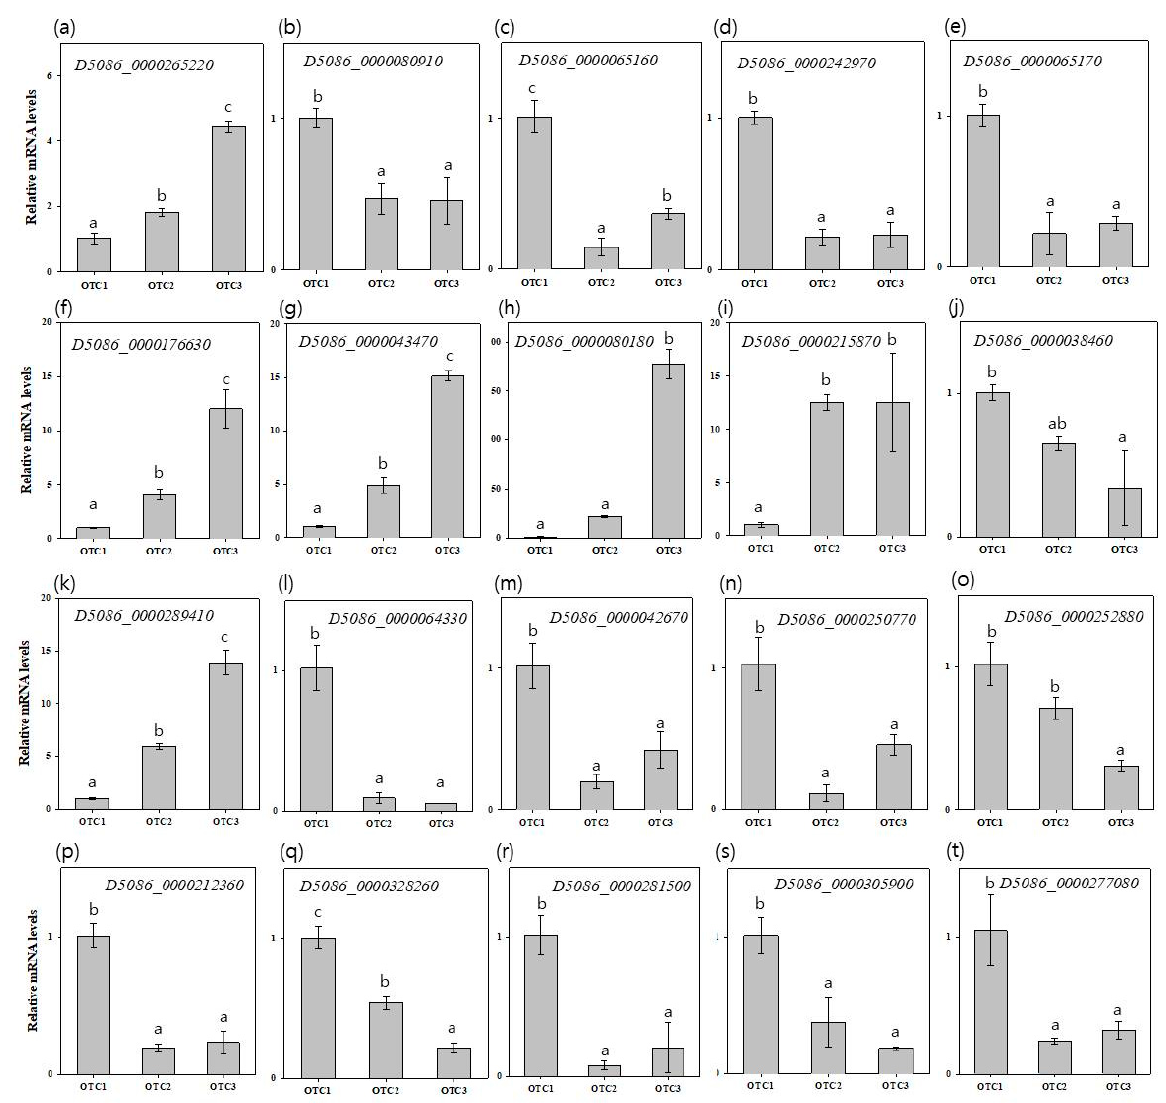
Figure 8 . Validation of differential expressions of 20 genes by quantitative real-time PCR (qRT-PCR). qRT-PCR analysis data for the top 10 most significantly differentially expressed genes (DEGs) in Clivus and I-476, respectively. qRT-PCR data were analyzed using the 2 − ΔΔ Ct method with Actin1 gene as an internal control. Three biological replicates were per- formed for each sample. Error bars show mean standard error (n = 3). ( a – e ) Common Clivus genes; ( f – j ) common I-476 genes; ( k – o ) sucrose genes of Clivus; and ( p – t ) sucrose genes of I-476. Different lowercase letters indicate significant dif-